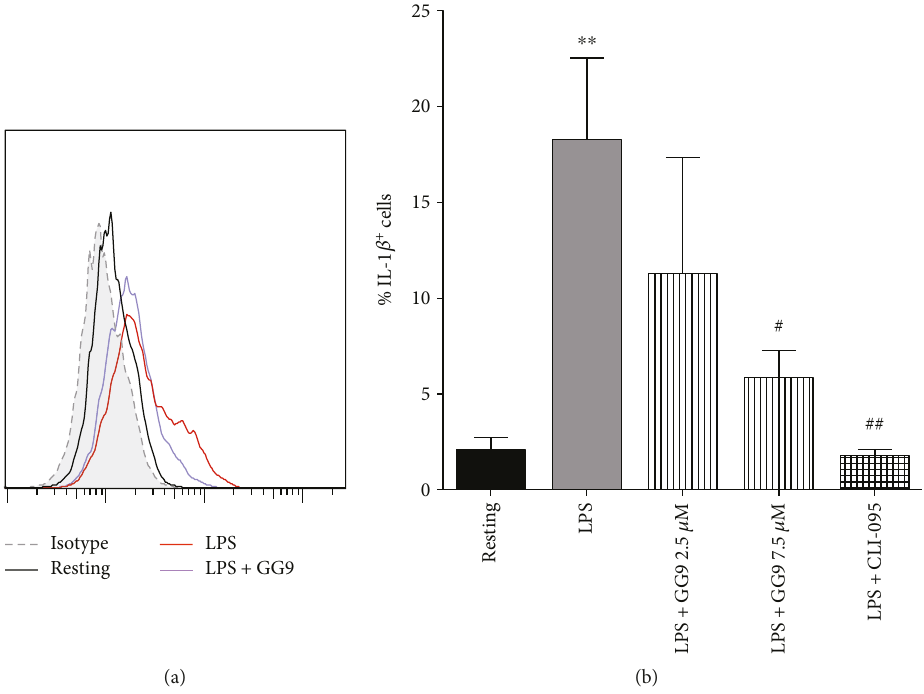
Figure 6: E ff ects of GG9 and CLI-095 on cell-bound IL-1 β expression in LPS-stimulated macrophages. After di ff erentiation, macrophages were pretreated with either GG9 or CLI-095 for 30 min, and then incubated with LPS for 24 h at 37 ° C in RPMI +10% FBS in the presence of brefeldin (10 μ M) over the last 4h to disrupt cytokine secretion pathways. Prior to fl ow cytometry analysis, fi xed/permeabilized cells were stained with anti-IL-1 β antibodies. Fluorescence plots are from representative experiments (a), and bar graphs represent the mean ( ± SEM) of 5 independent experiments (b). ∗∗ p < 0 01 versus resting; # p < 0 005 ; and ## p < 0 001 versus LPS.